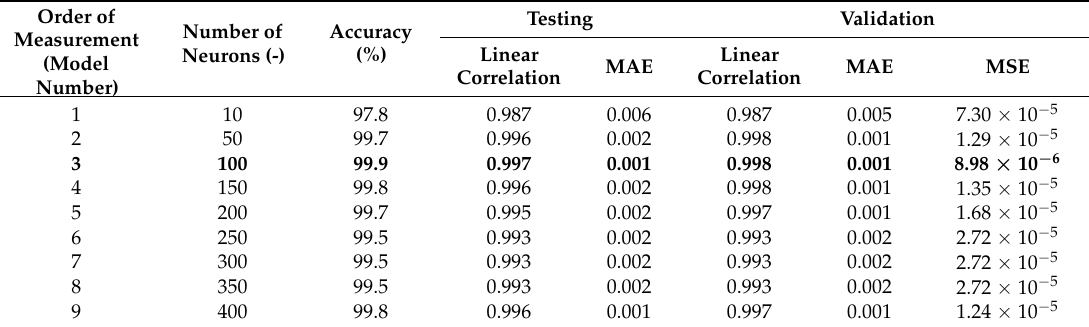
Table 6. The trained models—Training period: 15 th of May 2018.